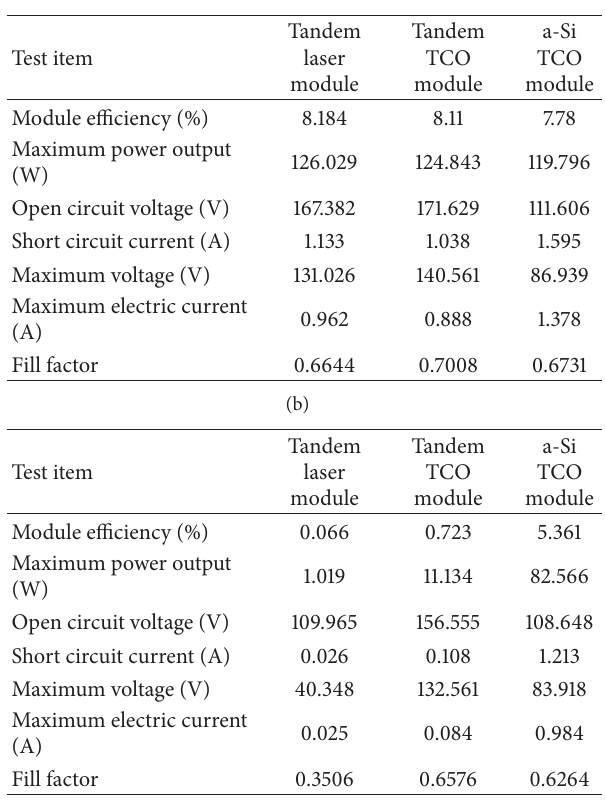
Table 4: Results of tests of electrical characteristics in STC for initial states of the original transparent PV module: (a) front side and (b) back